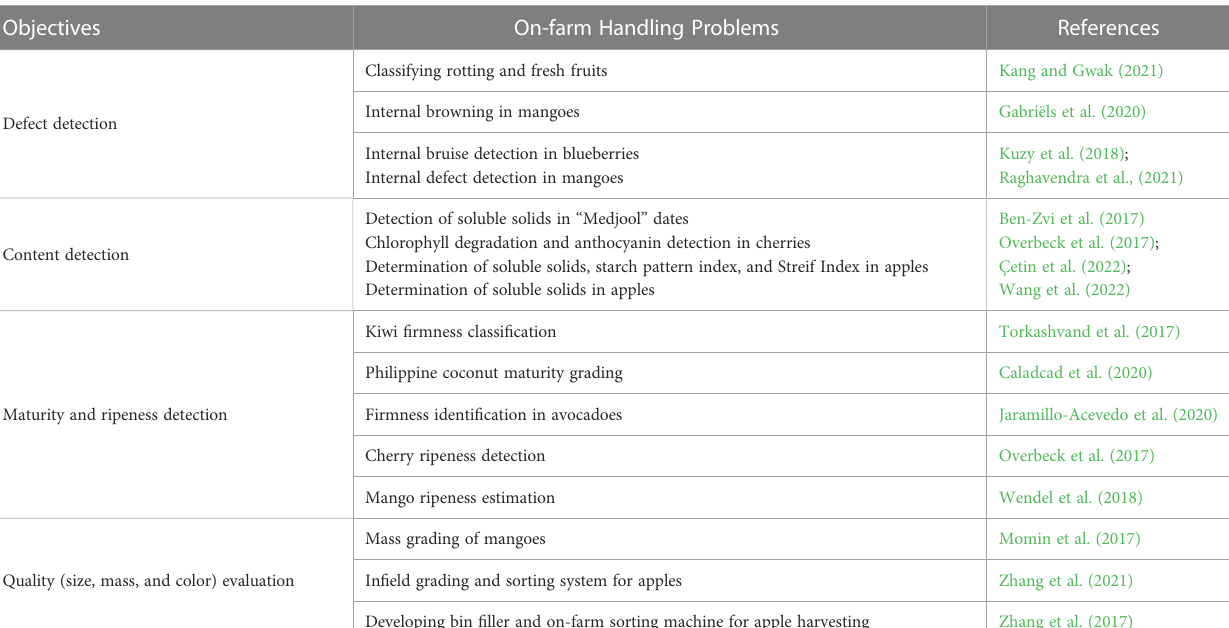
TABLE 1 On-farm sorting tasks solved by AI